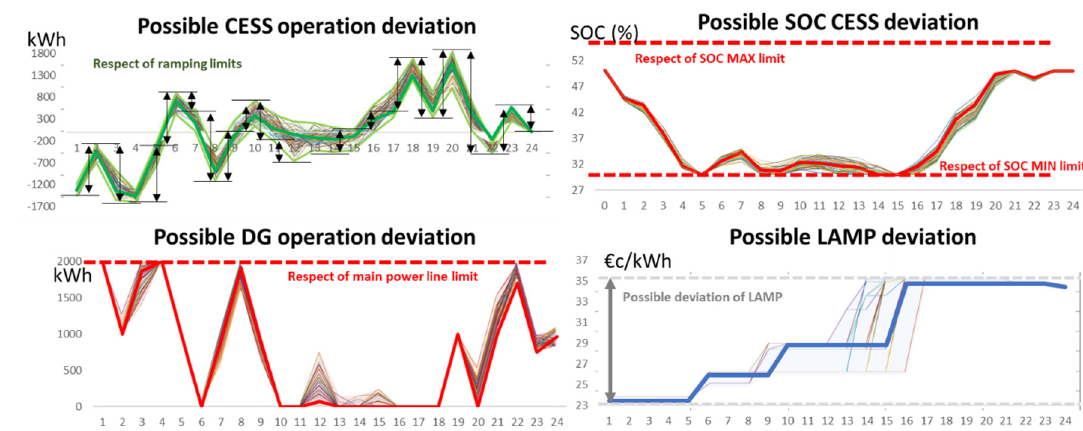
Figure 13. DA-OPF evaluation—possible assessment of different DA-OPF parameters (winter case).